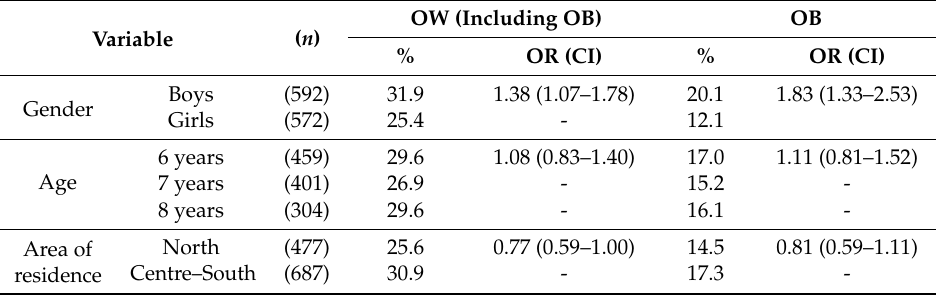
Table 1. Characteristics of the children in the MAPEC_LIFE (Monitoring Air Pollution Effects on Children for Supporting Public Health Policy) cohort.